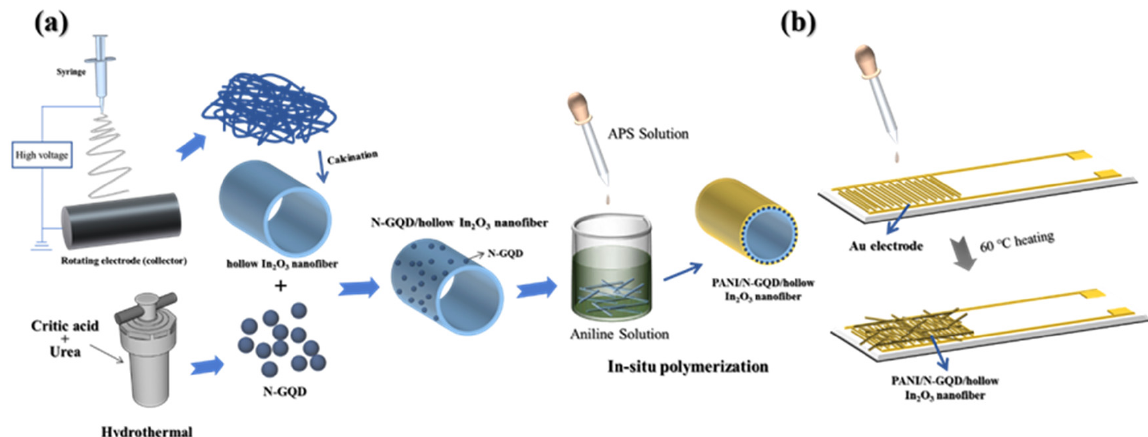
Scheme 1. The schematic illustration of ( a ) preparation of hollow In 2 O 3 nanofibers, N-GQDs, and PANI/N-GQD/hollow In 2 O 3 nanofiber composites and ( b ) preparation of the PANI/N-GQD/hollow In 2 O 3 nanofiber sensor.